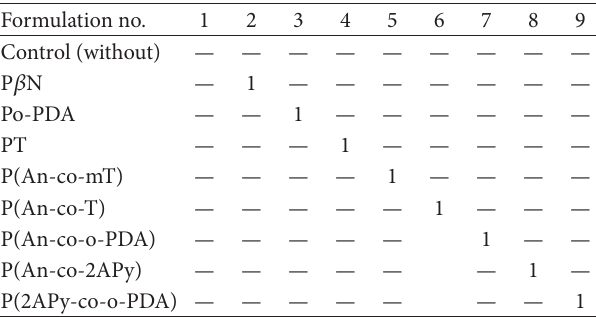
Table 1: Rubber formulations containing the prepared homopoly- mers and copolymers. Formulation